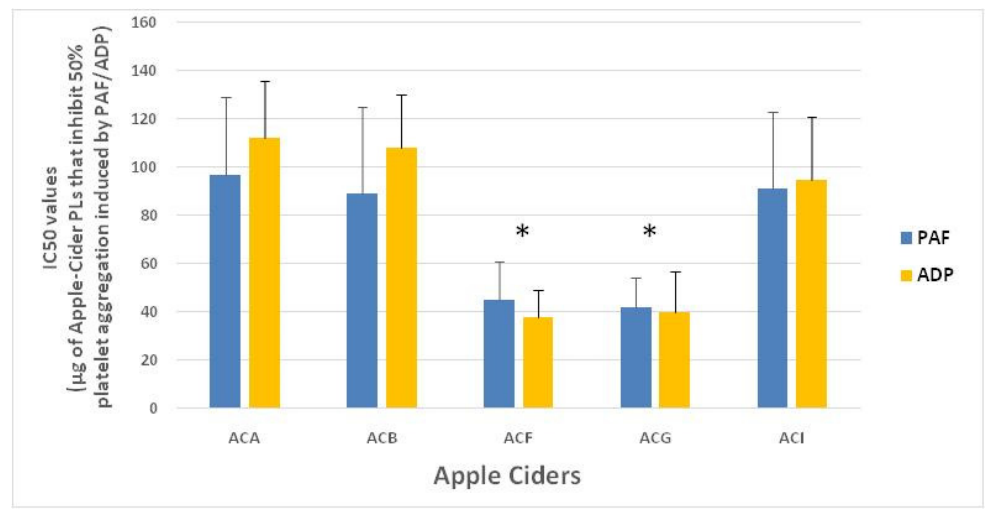
Figure 2. The anti-platelet potency of PL extracts from the novel functional apple ciders (AC) ACA, ACB, ACF, ACG and ACI, which were produced by fermenting apple juice inoculated with the A, B, F, G, and I apple must yeast strains, respectively, as assessed against human platelet aggregation induced by the inflammatory and thrombotic mediator PAF (blue bars) or by the platelet agonist ADP (yellow bars). Results are expressed as means of the IC50 (half-maximal inhibitory concentrations) values in μ g of apple cider PL in the aggregometer cuvette that causes 50% inhibition of PAF/ADP-induced platelet aggregation (the lower the IC50 value for a lipid extract the higher its inhibitory effect against the specific agonist of platelet aggregation). * denotes statistically significant difference ( p < 0.05) when the anti-PAF and/or anti-ADP potency (IC50 value) of the bioactive PL extracts were compared within all novel functional apple ciders. Abbreviations: PL, polar lipids; PAF, platelet-activating factor; ADP, adenosine 5 ′ diphosphate.